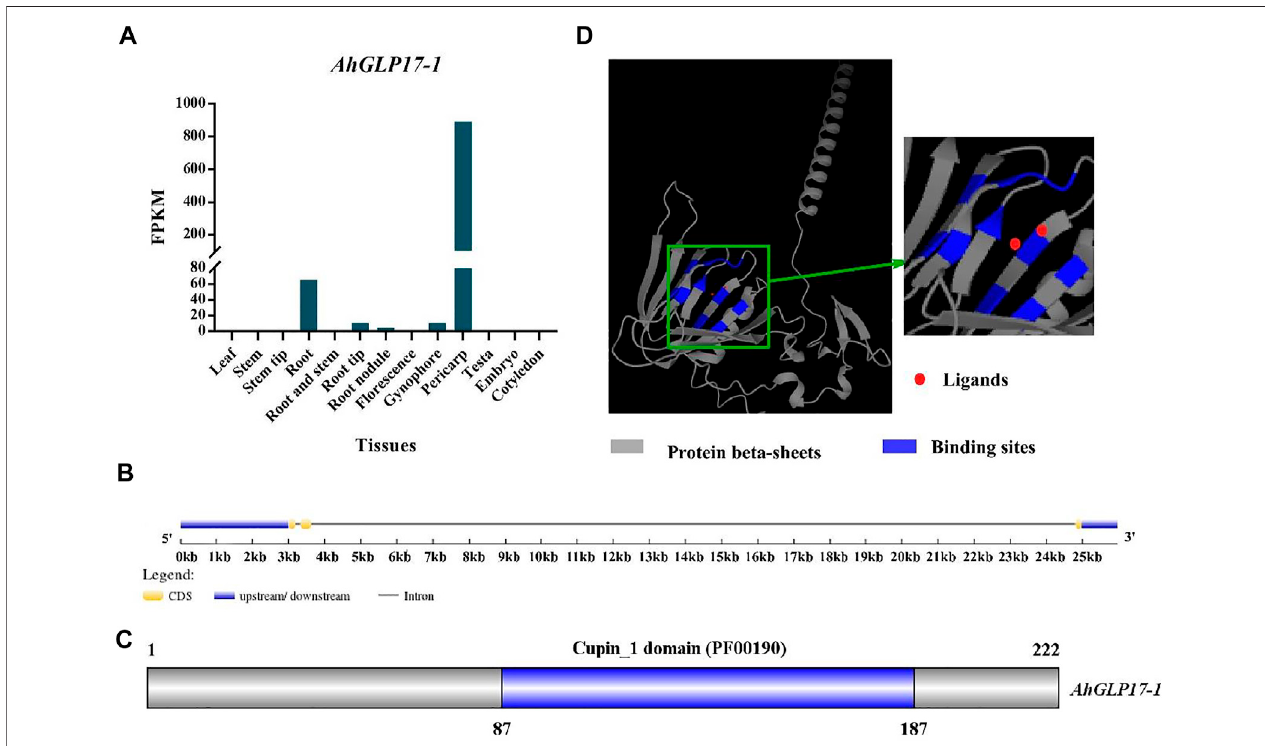
FIGURE 1 | Expression and characterization of AhGLP17-1 gene. (A) Transcriptome expression (FPKM values) of the AhGLP17-1 gene in different tissues of peanut (average values of the pericarp, testa, and embryo transcriptome expression are used). (B) Gene structure of AhGLP17-1 . (C) The position of cupin_1 domain. (D) The 3D protein structure of AhGLP17-1 . Where grey color shows the protein β -sheets, blue color shows binding sites, and red dots show